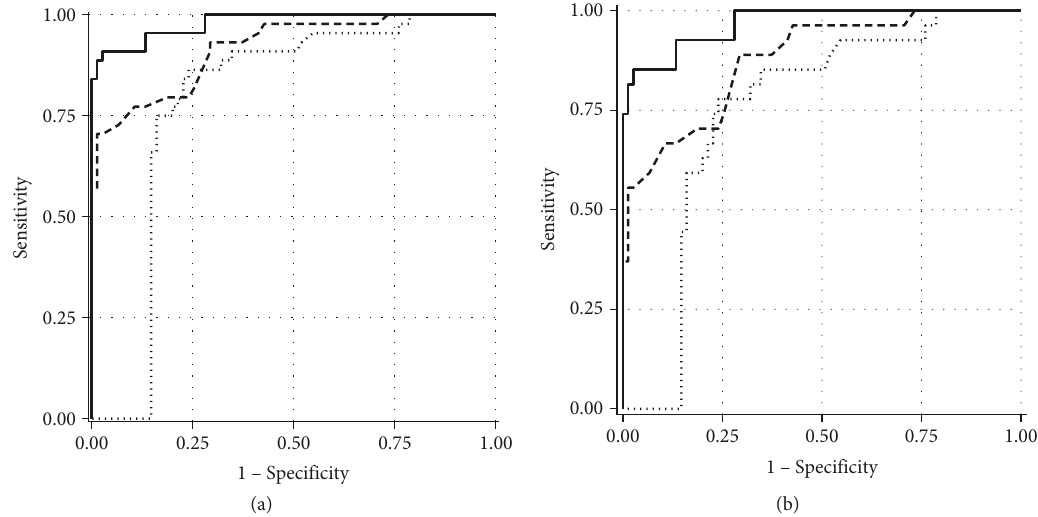
Figure 1: Receiver operating characteristic (ROC) curves for discriminating between the healthy and glaucomatous eyes. (a) The area under ROC curves was 0.98, 0.92, and 0.79 for estimated retinal ganglion cell (RGC) count, average retinal nerve fi ber layer (RNFL) thickness, and standard automated perimetry mean deviation (SAP MD), respectively. (b) When eyes with MD < − 6dB were excluded, estimated RGC count also showed better diagnostic performance (area under ROC curves of 0.97, 0.88, and 0.75; P < 0 001 ). Black line: estimated RGC count; dashed line: average RNFL thickness; dotted line: SAP